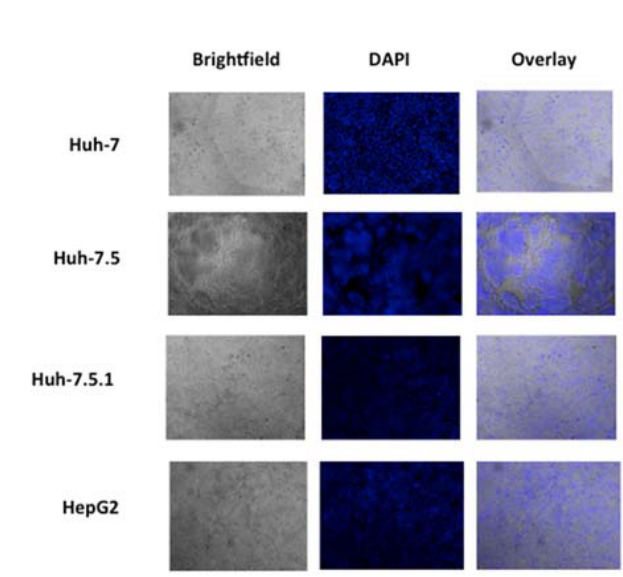
Figure 3. Syncytia formation in liver cell lines. ( a ) Cells were infected at an MOI of 5 for 72 h followed by fixation with formalin and 4 ʹ ,6 ‐ diamidino ‐ 2 ‐ phenylindole (DAPI) staining. ( b ) No syncytial formation was observed in uninfected cells. Cells were analyzed by fluorescence and bright ‐ field microscopy (100× magnification).